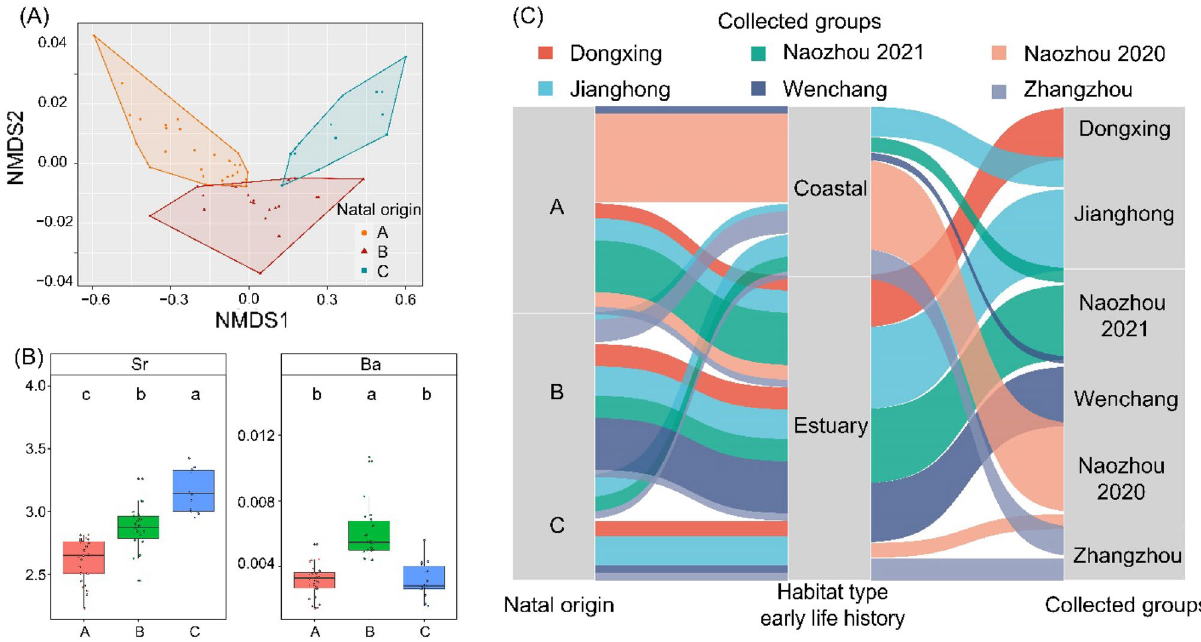
Figure 8. ( A ) Clustering based on otolith chemistry in the larval period for fourfinger threadfin. ( B ) Comparison of dominant clusters ( A – C ) based on otolith chemistry in the larval period. ( C ) Frequency distribution of fourfinger threadfin (n = 64) by cluster for the three natal origin, two habitat type and six collected groups studied. The height of each box represents the proportion, the size of color lines indicates the proportion of